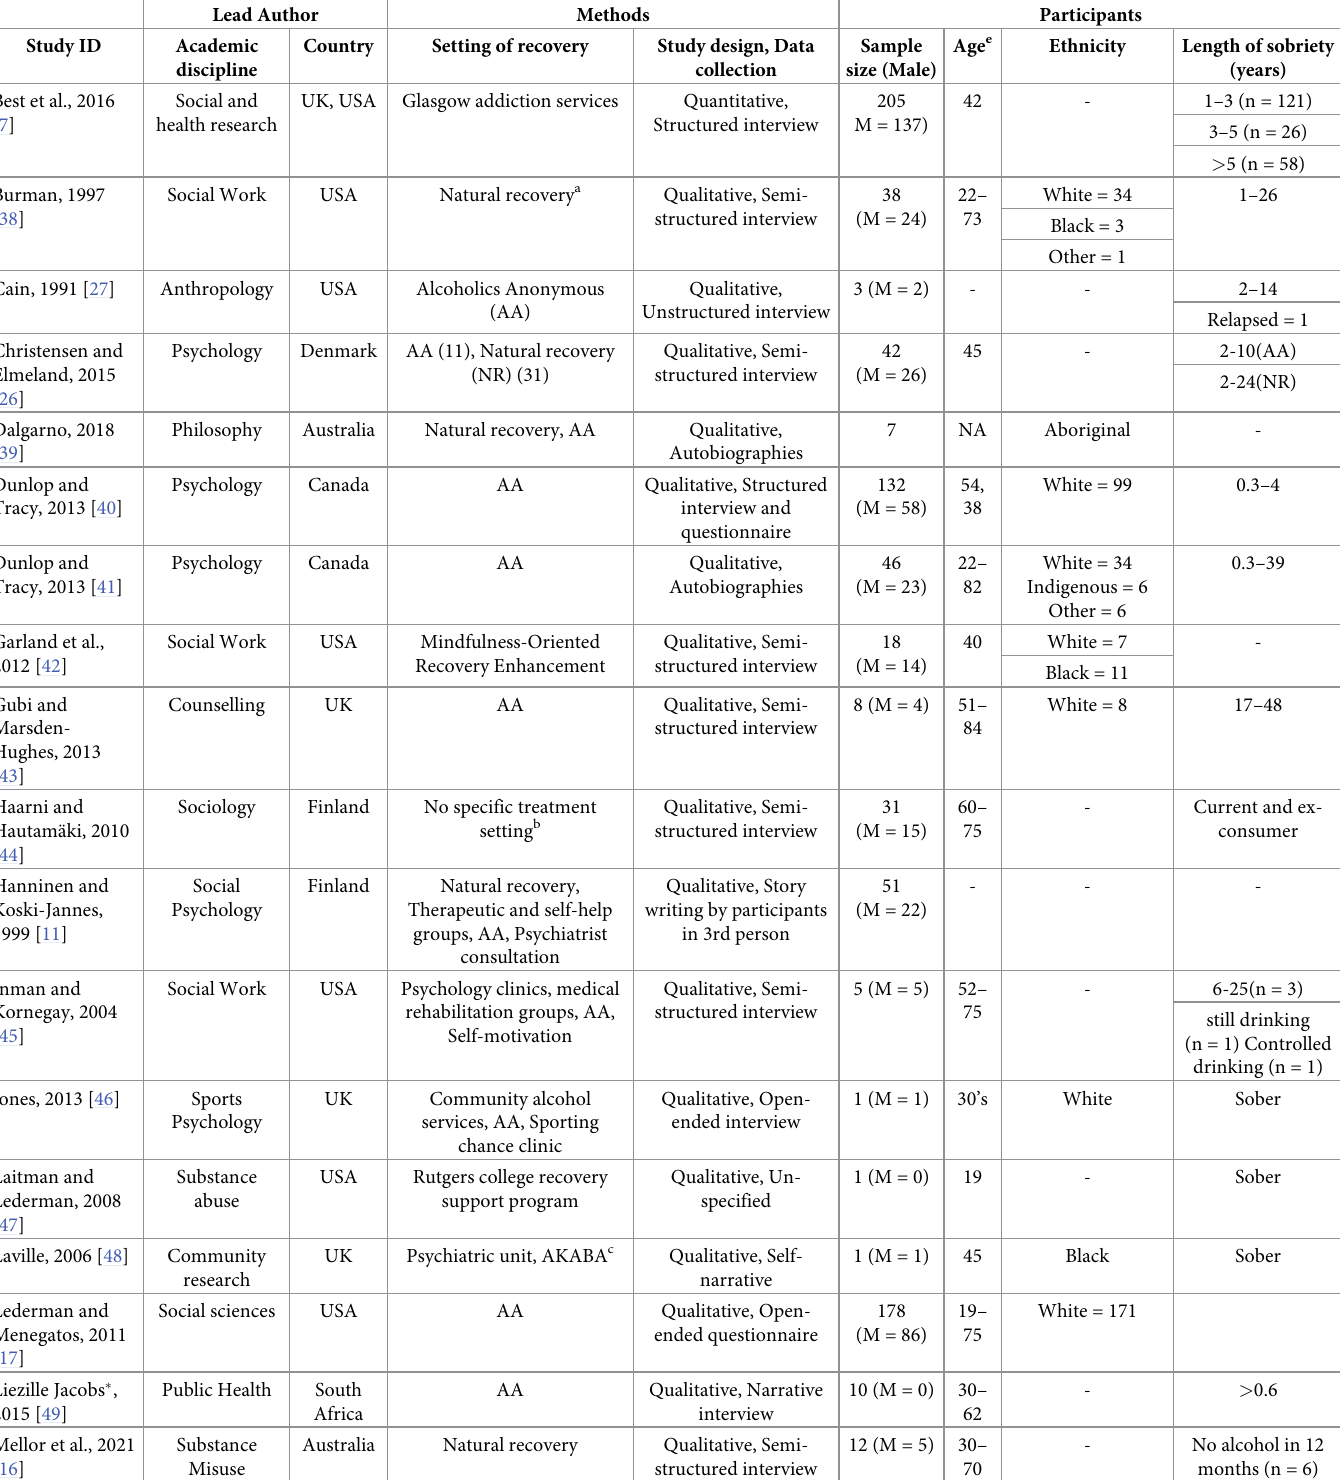
Table 1. Characteristics of included studies and